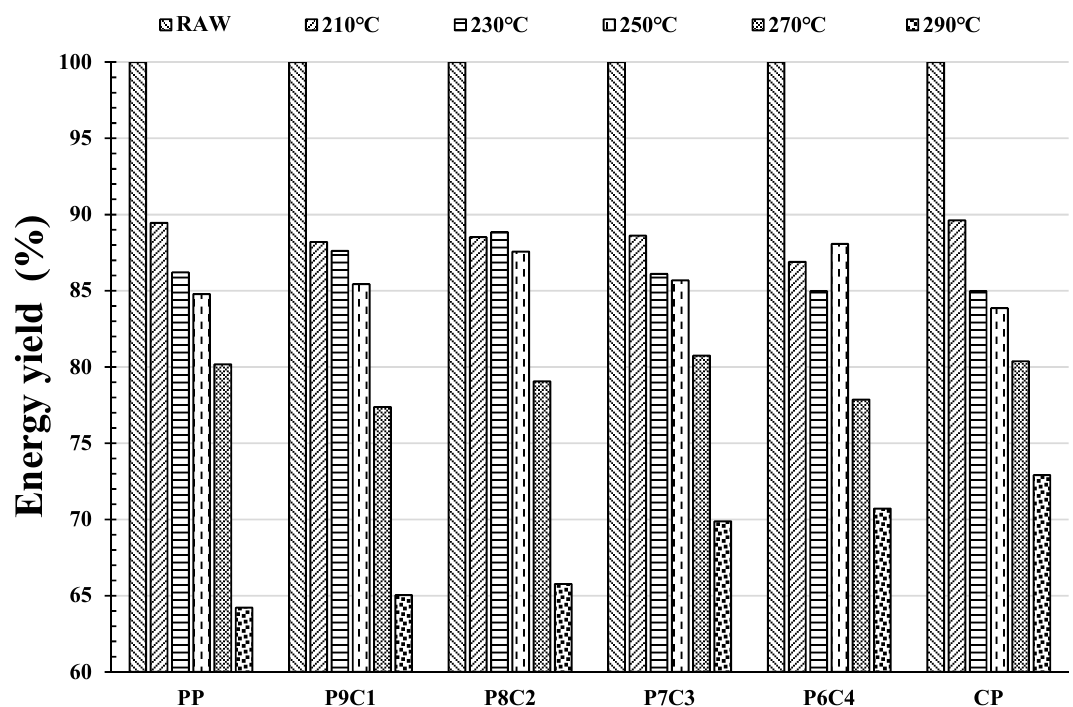
Figure 7. Changes in the energy yield of different pellets, with different torrefaction temperatures.